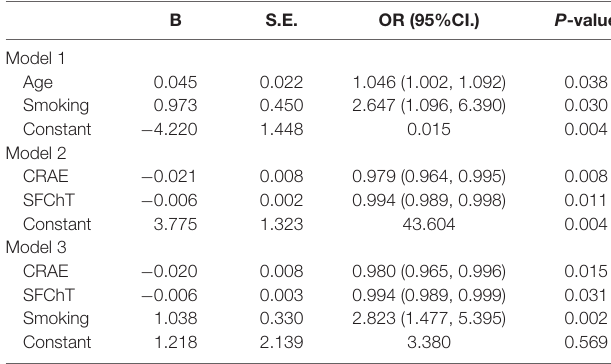
TABLE 3 | Logistic regression of ischemic stroke with risk factors or/and ocular